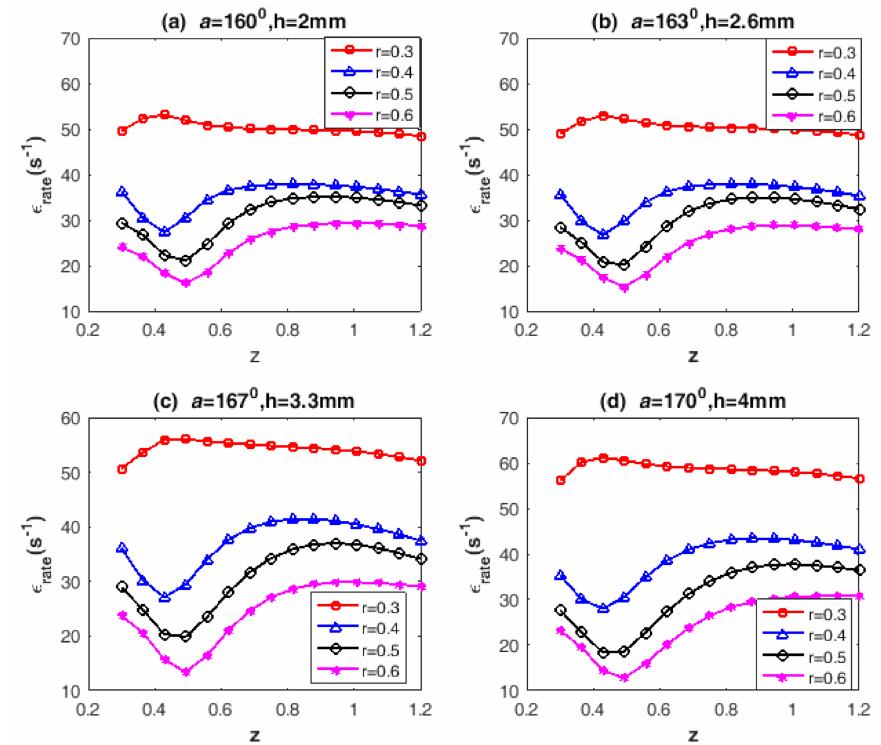
Figure 9. E ff ect of billet size ratio on the e ff ective strain rate with varying reduction ratios, punch angle ( a ), and land height (h) at ( a ) a = 160 ◦ , h = 2.0 mm; ( b ) a = 163 ◦ , h = 2.6 mm; ( c ) a = 167 ◦ , h = 3.3 mm; and ( d ) a = 170 ◦ , h = 4.0